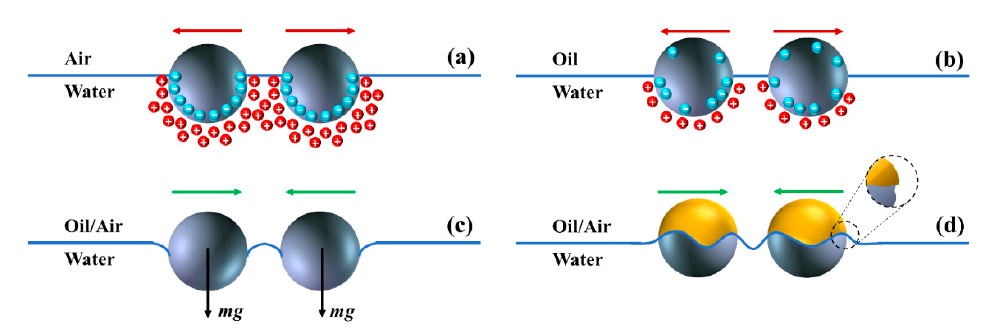
Figure 3. (Color online) Examples of interparticle interactions that can be present at fluid interfaces. ( a ) Dissociation of surface groups causing repulsive dipole-dipole interactions; ( b ) water entrapment on the particle surface in contact with the oil phase causing long-ranged repulsive interactions; ( c ) gravitational forces deforming the interface generating attractive capillary interactions; ( d ) interface undulations caused by surface roughness along the Janus boundary resulting in capillary interactions.